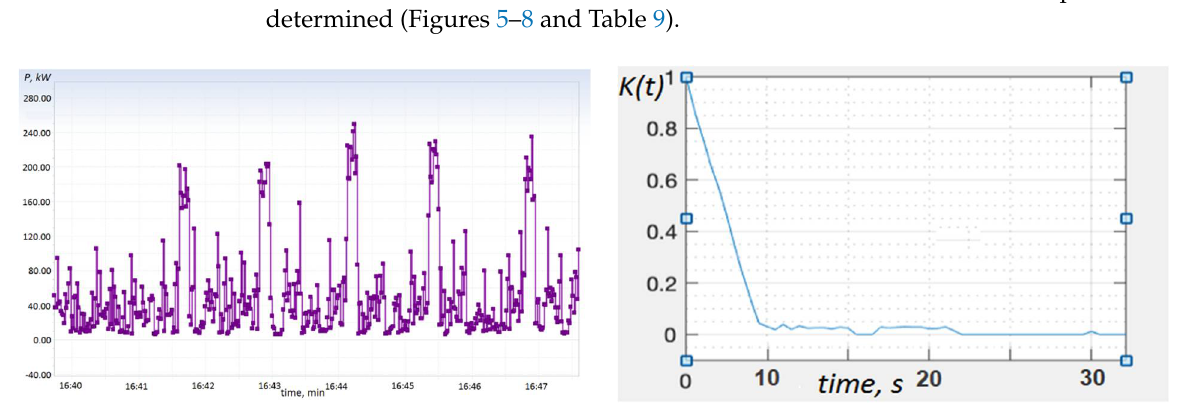
Figure 4. Theoretical NCF curve with a VFD.